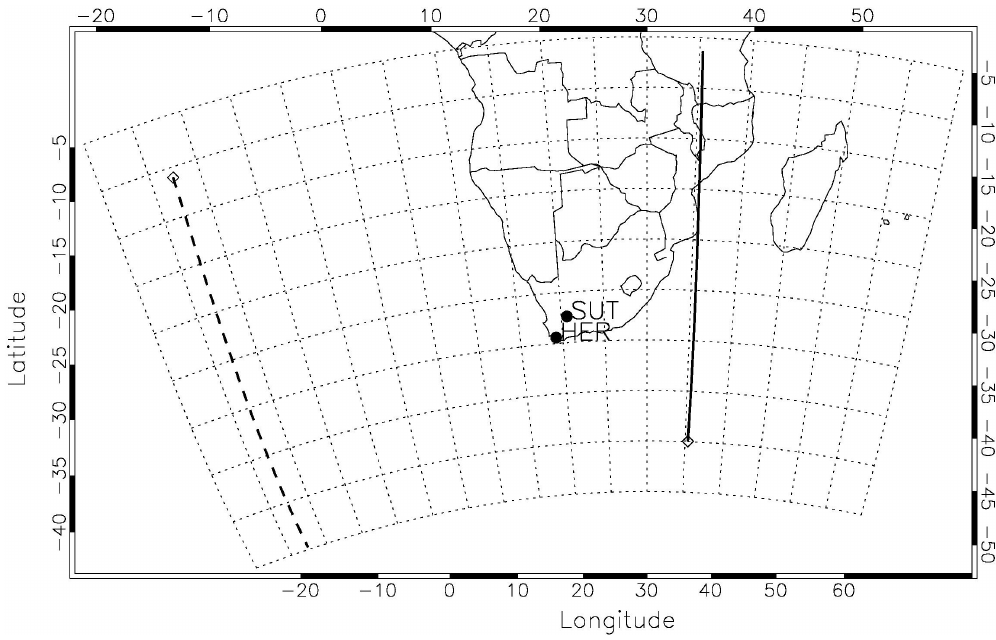
Fig. 1. Map of southern African region that also extends to central Africa showing the satellite ground tracks as it traversed the region during Pc3 pulsation activities of 13 February 2002 (solid line) and 18 February 2003 (dashed line). The locations of Hermanus and Sutherland ground stations are also shown.